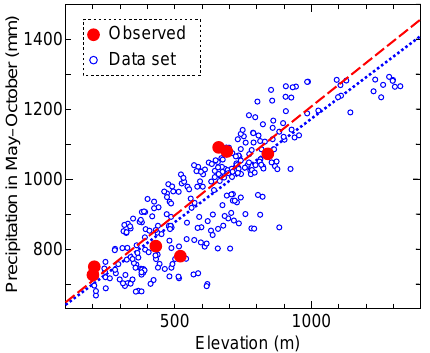
Figure A2. Altitudinal distribution of precipitation with elevation (ASE catchment, May–October).